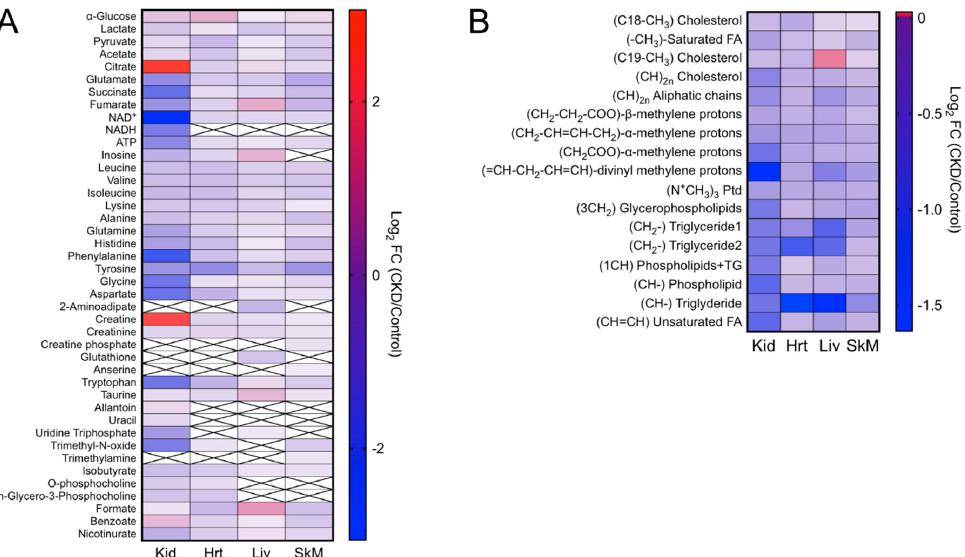
Figure 5. Heatmap representing the log 2 -transformed fold changes (CKD/control) of the metabolites measured in the ( A ) aqueous phase and ( B ) organic phase. Boxes with an “x” inside indicate that the specified metabolite was not detected in the respective tissue ( n = 7/group). FC: fold change, Kid: kidney, Hrt: heart, Liv: liver, and SkM: skeletal muscle.